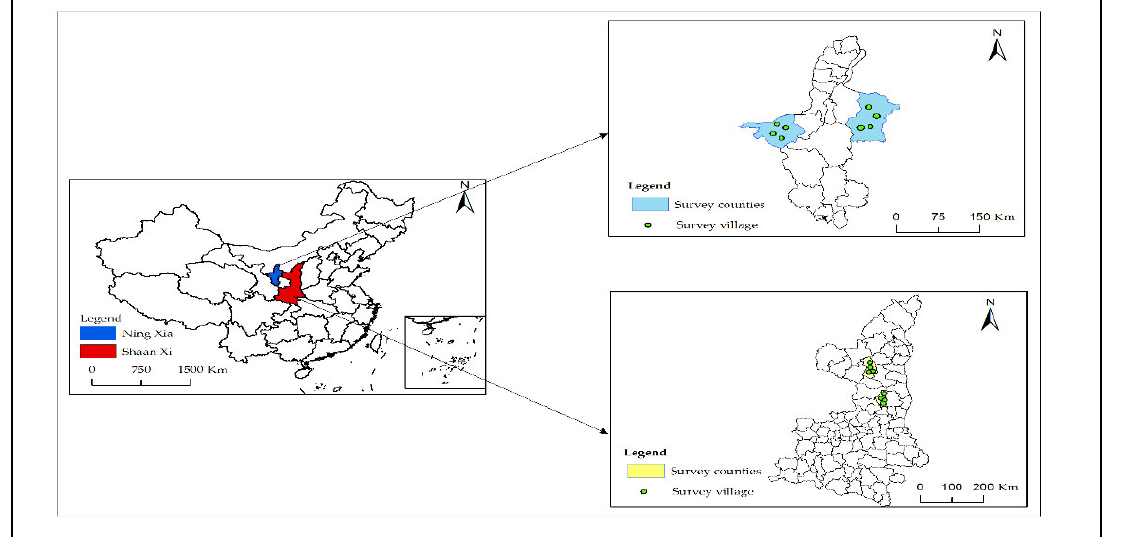
Figure 2. The study area.